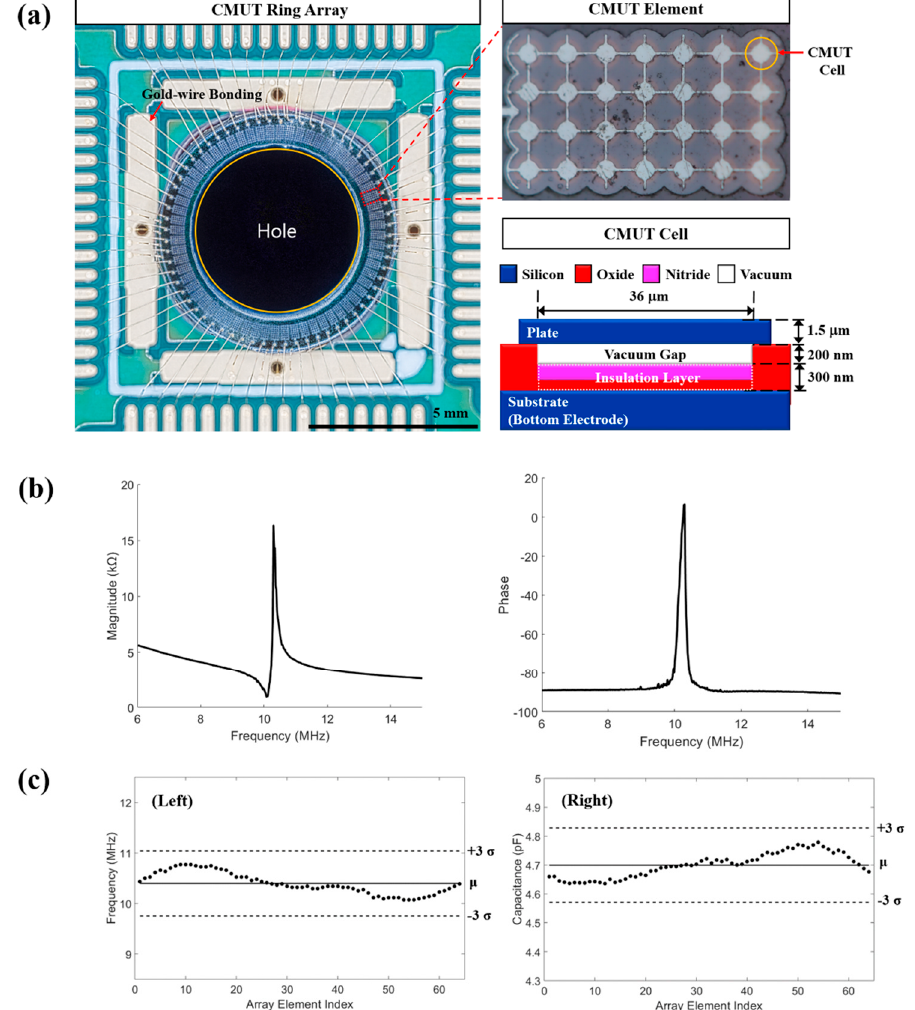
Figure 1. ( a ) Capacitive micromachined ultrasonic transducer (CMUT) ring array bonded with gold wire, closed CMUT element, and cross-sectional schematic of CMUT cell. ( b ) Measured magnitude and phase of electrical impedance ( c ) Measured resonance frequency in air (left) and capacitance (right) of elements.